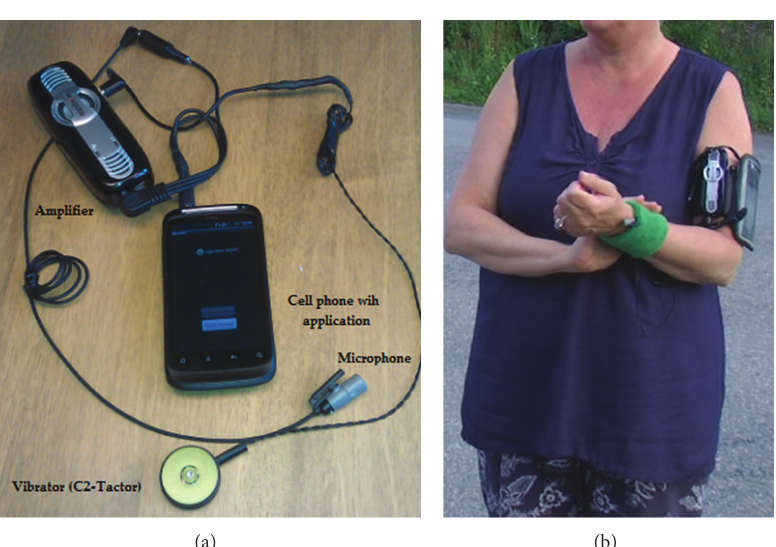
Figure 1: (a) Monitor and its parts, cell phone with the application, microphone, vibrator, and amplifier. (b) The P has the cell phone and the amplifier in the armband, the microphone on the dorsal side of the hand under the sweatband, and the vibrator on the palmar side of the hand under the sweatband. The P uses her right hand to feel the vibrations better.